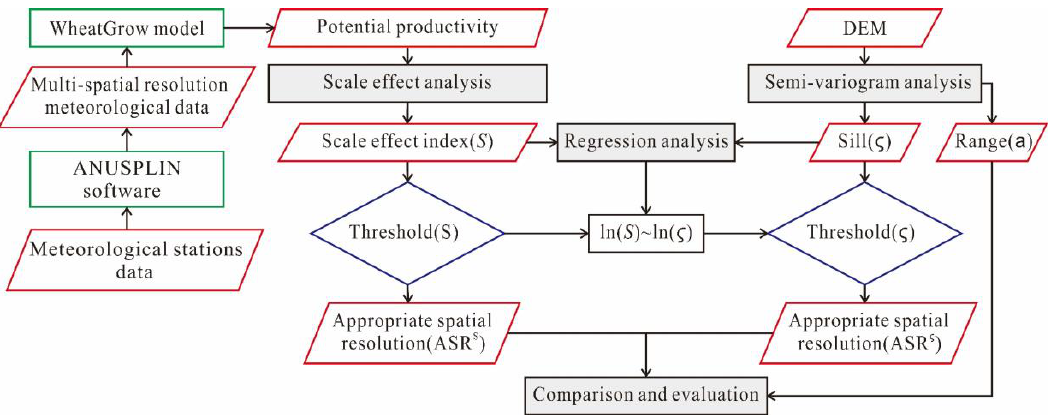
Figure 2. Workflow of analysis.